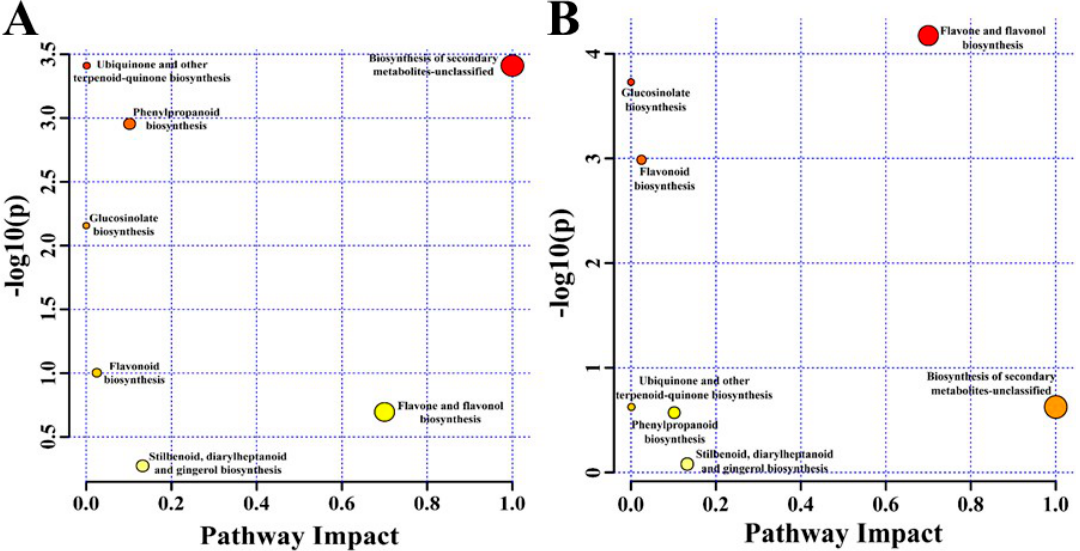
Figure 5. Identified secondary metabolites and their pathway impact in PGK ( A ) and PK ( B ) cultivars grown under light and dark conditions.